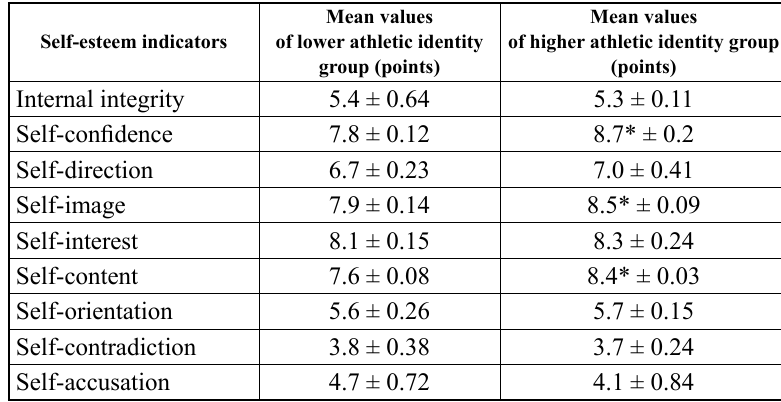
Table . Self-esteem of wheelchair basket - ball players